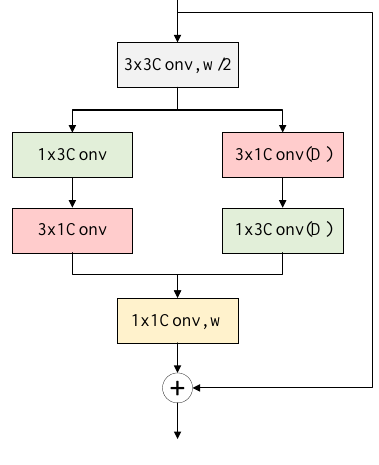
Figure 4. Structure of the EFA